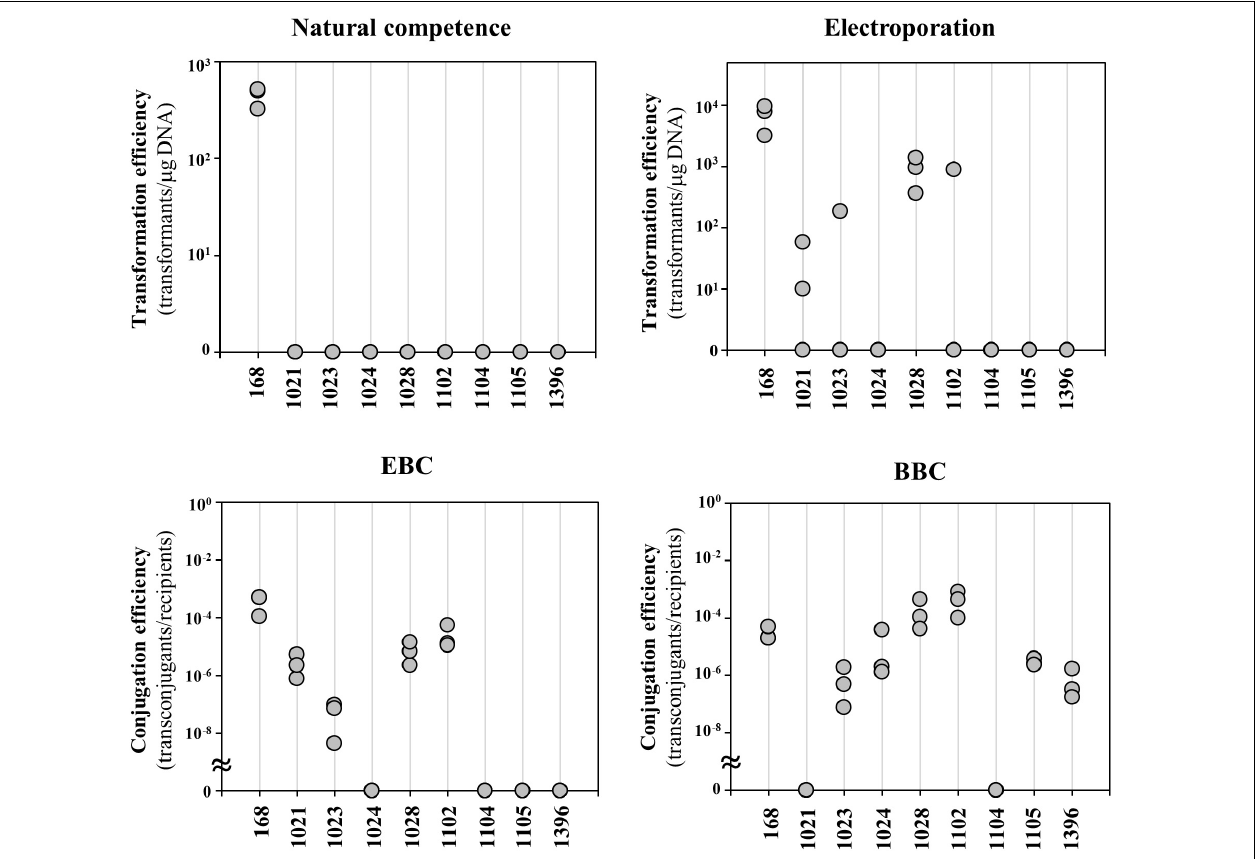
FIGURE 1 | Comparison of conventional transformation and conjugation methods for undomesticated Bacillus subtilis strains. Transformation efficiency for natural competence and electroporation was calculated as colony forming unit per µ g DNA used. E. coli- to- Bacillus conjugation (EBC) used E. coli S17-1 as a donor. Bacillus -to- Bacillus conjugation (BBC) used B. subtilis 168 containing plasmid pLS20 as a donor. The conjugation efficiency for EBC and BBC were calculated by dividing the number of transconjugants by the number of recipient cells. The numbers are KCTC strain numbers and the 168 indicates B. subtilis strain 168. Three independent experiments were performed and the results are presented as closed